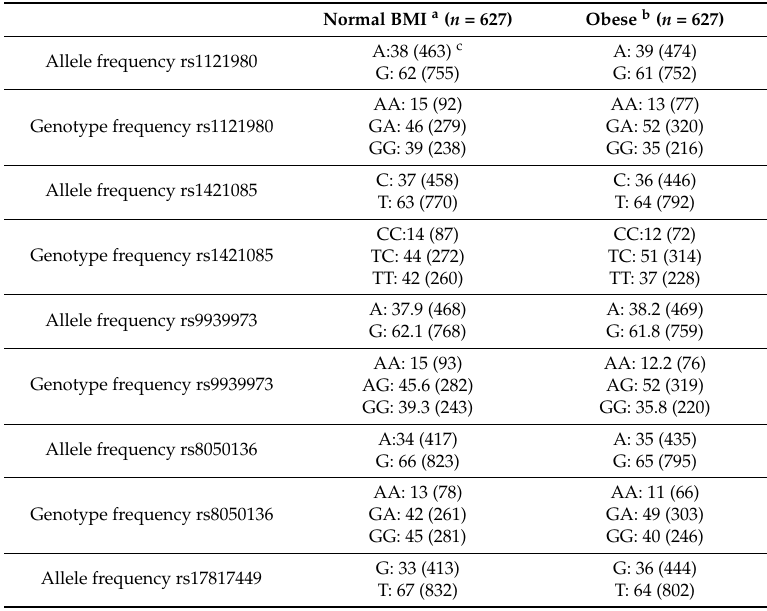
Table 2. Allele and genotype frequency of FTO SNPs in cases (obese) and controls (non-obese): Tehran Lipid and Glucose